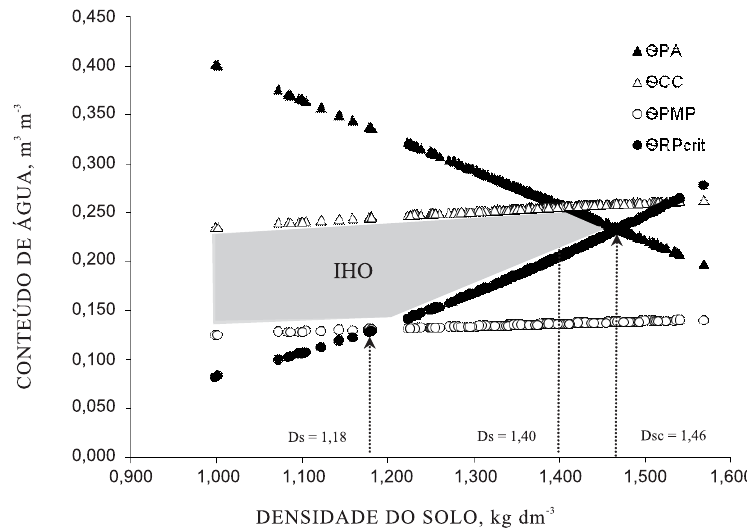
Figura 2. Variação do conteúdo de água volumétrico ( θθθθθ ) com a densidade do solo, para limites críticos da porosidade de aeração ( θθθθθ ), capacidade de campo ( θθθθθ ), resistência do solo à penetração de 2,15 MPa PA CC ( θθθθθ ) e ponto de murcha permanente ( θθθθθ ) no Latossolo Vermelho distrófico típico. IHO: intervalo RPcrit PMP hídrico ótimo; Ds: densidade do solo; Dsc: densidade crítica do solo, na profundidade de 0–30